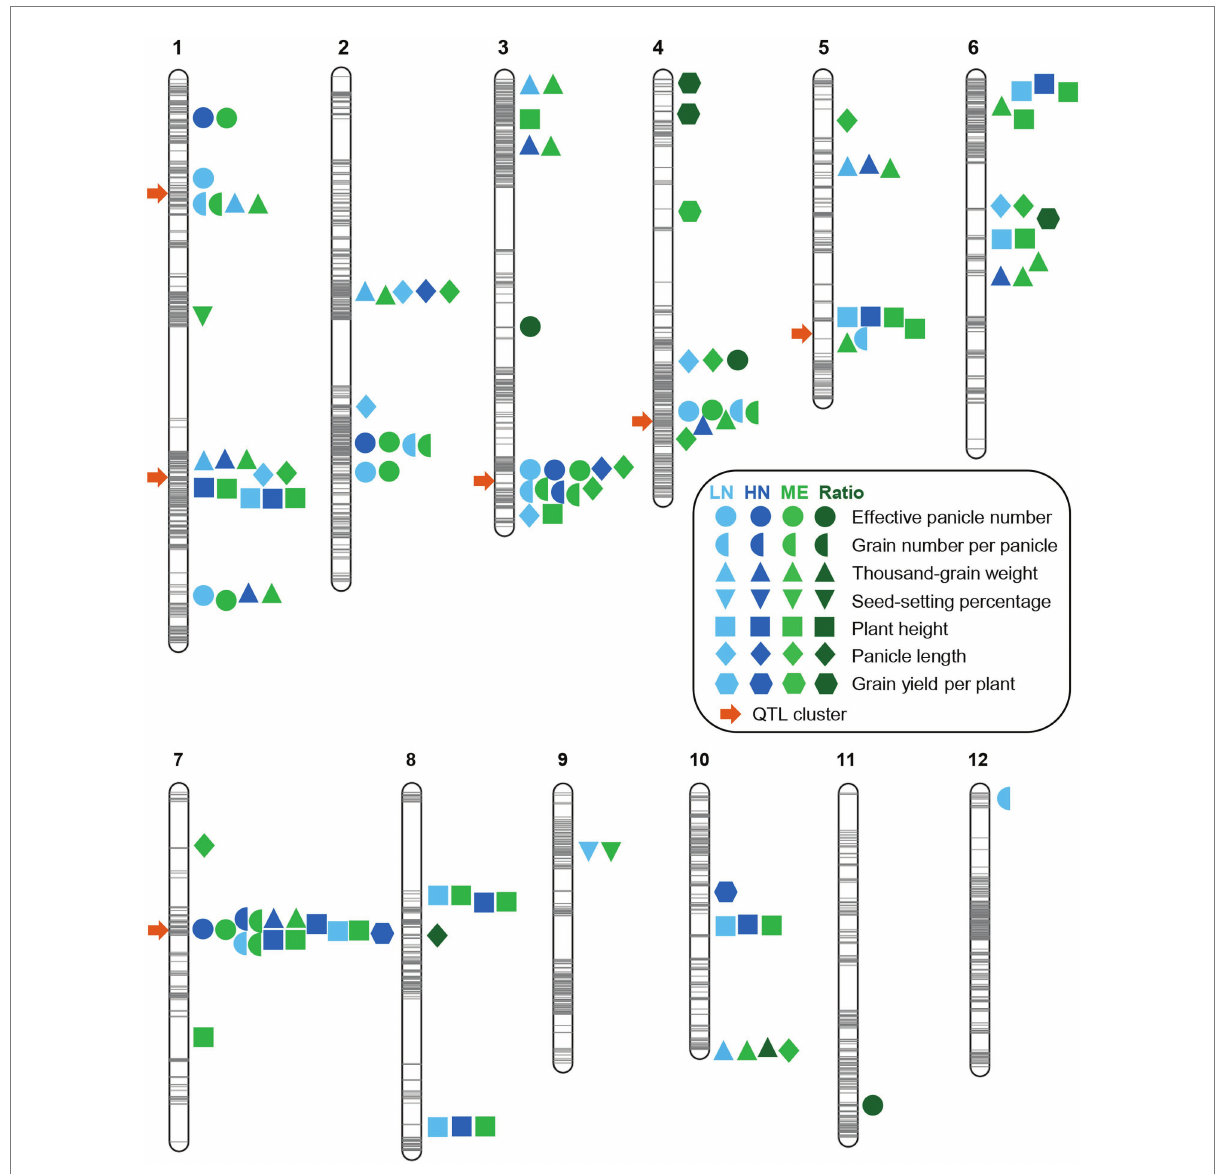
FIGURE 3 Summary of QTL locations on the linkage map of the RIL population. The gray lines on the chromosomes show the genetic positions of the markers. The light blue, dark blue, light green, and dark green symbols on the right of the chromosomes indicate the LN (low nitrogen), HN (high nitrogen), ME (multi-environment), and ratio trait-related QTLs, respectively. The orange arrows on the left of the chromosomes indicate QTL